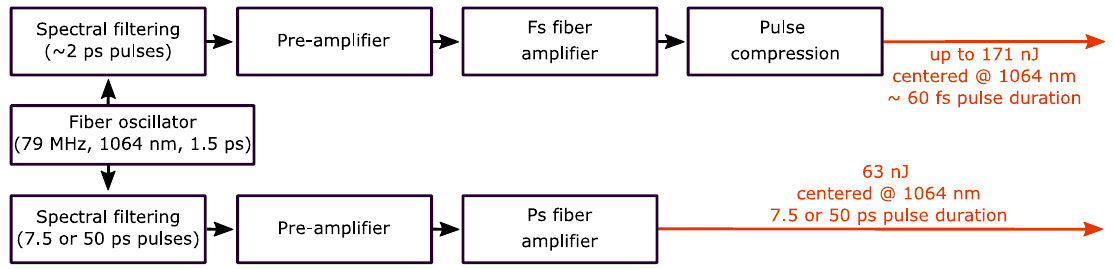
Fig. 1 Schematic overview of the laser system with its two amplifer